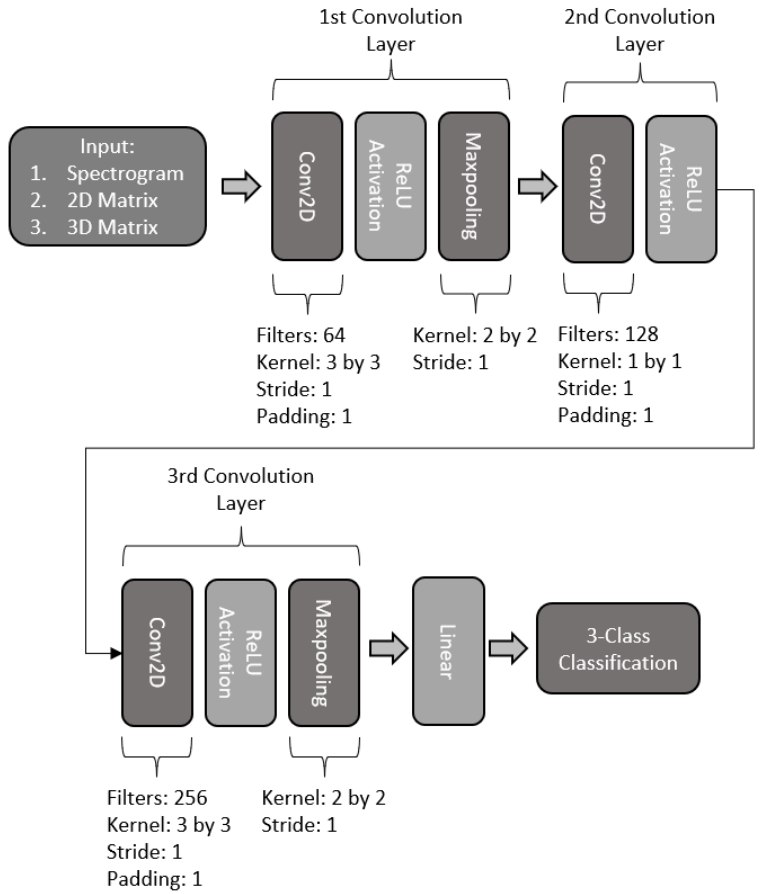
Figure 13. Architecture of three-layered CNN